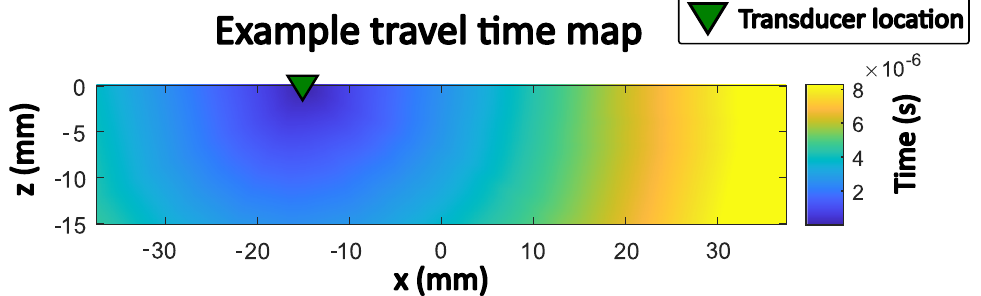
Figure 4. Example travel time map given by the anisotropic multi-stencil fast marching method [4] through a weld model parametrised with grain orientations given by the Ogilvy model (shown in Figure